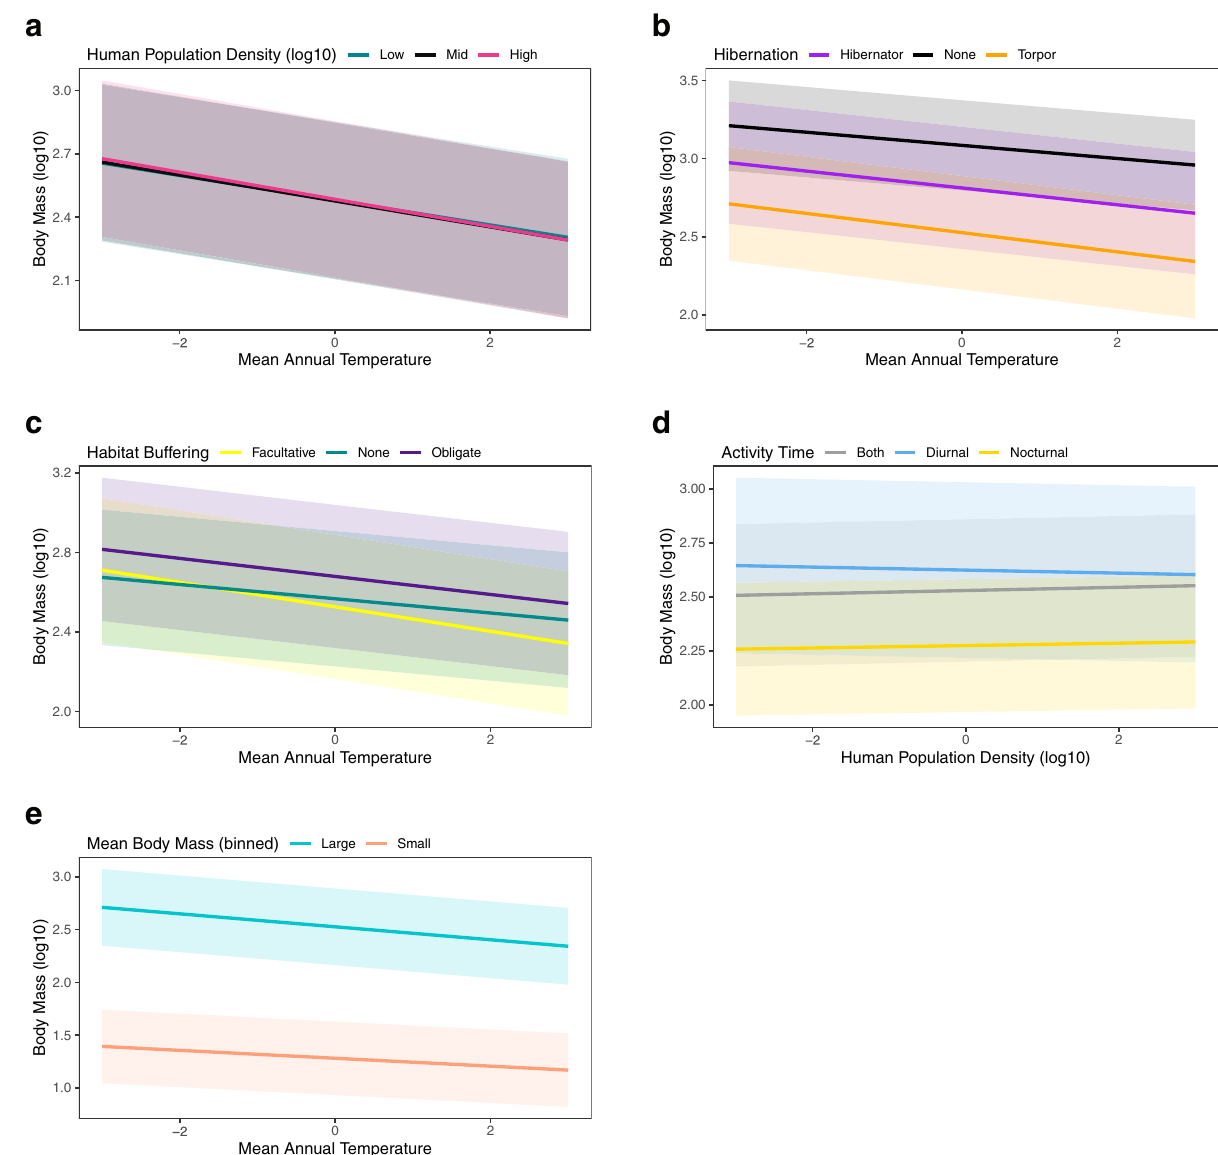
Fig. 2 Mammal body mass interactions. Mammalian body mass is in fl uenced by the interaction between ( a ) human population density and mean annual temperature; ( b ) hibernation ability and mean annual temperature; ( c ) habitat buffering and mean annual temperature; ( d ) activity time and human population density; ( e ) and large/small size and mean annual temperature. Predictor variables (mean annual temperature and human population density) were mean-centered and standardized. Error bars in each plot represent 95% credible